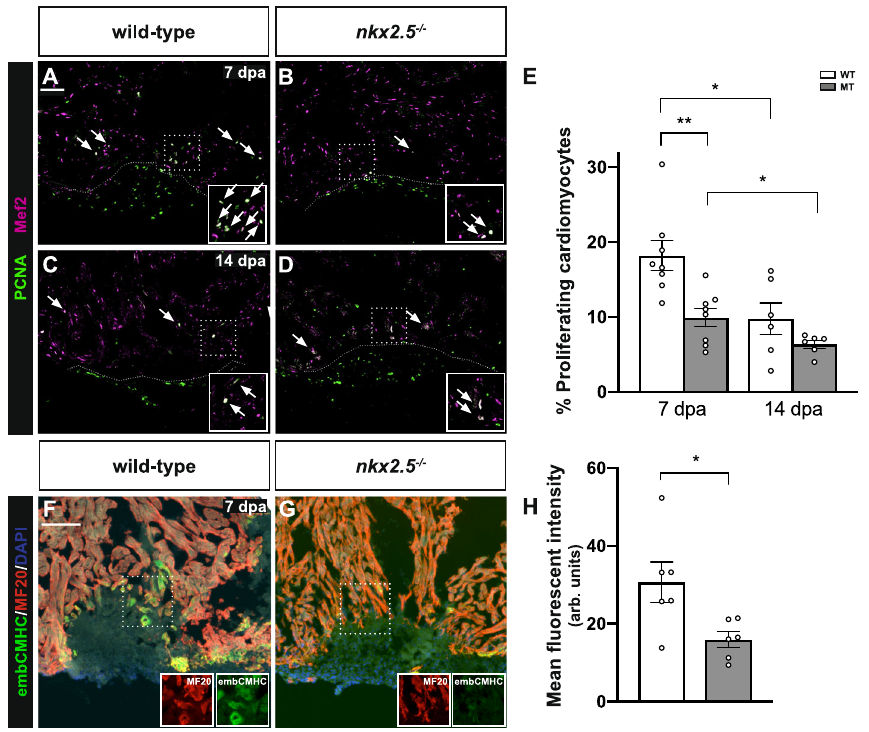
Fig. 8 Nkx2.5 is required for cardiomyocyte proliferation and dedifferentiation in the regenerating heart. A – D Representative images of PCNA/Mef2 immunostaining in wild-type ( n = 8 in A , n = 6 in C ) and nkx2.5 − / − ( n = 8 in B , n = 6 in D ) hearts indicate proliferating CMs (arrows). Scale bar, 100 μ m. E Quanti fi cation of PCNA + Mef2 + cells in wild-type and nkx2.5 − / − hearts. n = 8 at 7 dpa and n = 6 at 14 dpa for both genotypes. Mean and standard error of each data set is shown. Unpaired, two-tailed t -tests show statistical differences between WT7 and MT7 ( p = 0.0033), WT7 and WT14 ( p = 0.0143), and MT7 and MT14 ( p = 0.0369). F , G Representative images of embCMHC/MF20 immunostaining illustrating diminished expression of immature myosin in the nkx2.5 − / − ( n = 6) compared to the wild-type ( n = 6) wound border. Scale bar, 100 μ m. H Quanti fi cation of integrated signal density of the embCMHC stain is depicted in wild-type ( n = 6) and nkx2.5 − / − ( n = 6) injury borders. Mean and standard error of each data set are shown. Unpaired, two- tailed t -test indicates a statistically signi fi cant difference ( p = 0.0248). Source data are provided as a Source Data fi